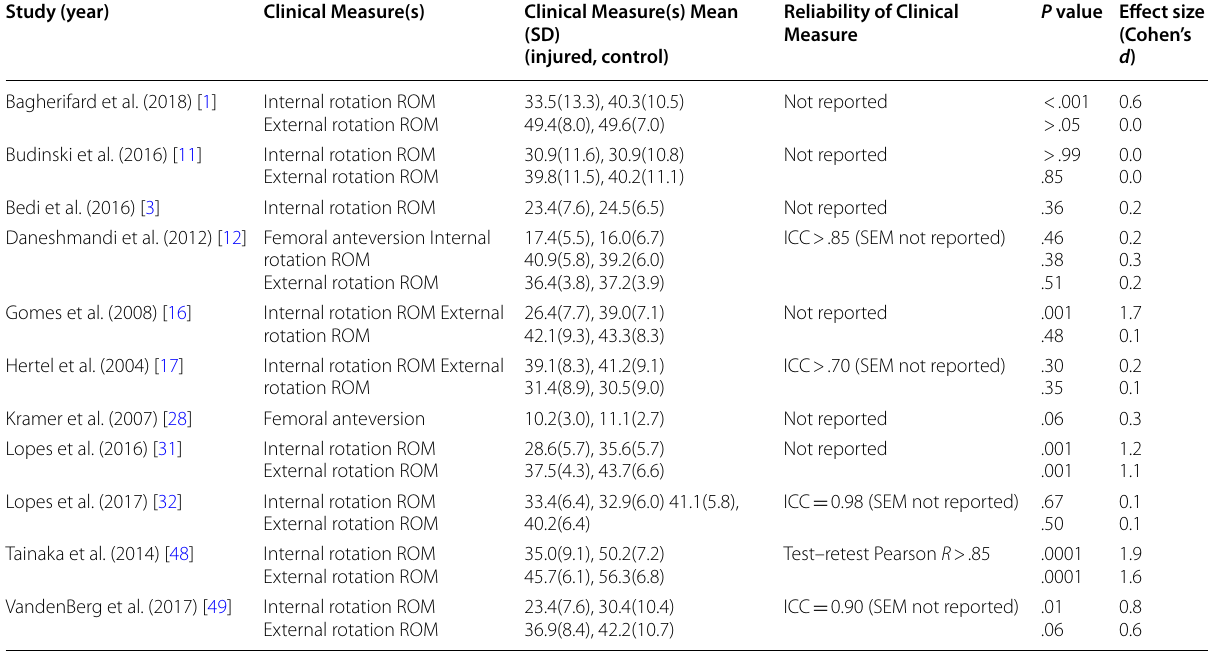
Table 5 Results of studies examining the relationship between transverse plane femoral alignment and history of ACL injury